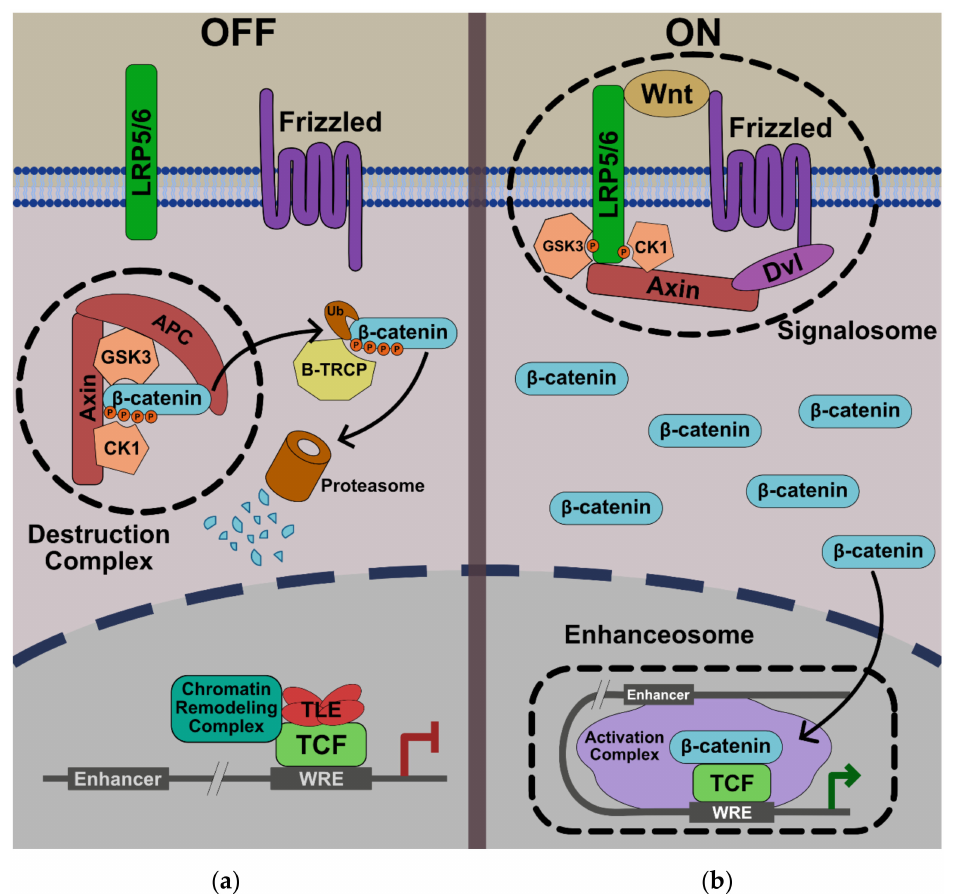
Figure 1. Model of the Wnt pathway. ( a )—ln the absence of Wnt ligand, the β -catenin β destruction complex maintains low cytoplasmic levels of β -catenin. ( b )—In the presence of Wnt ligand, the signalosome is assembled and the β -catenin degradation is disrupted. Entry of β -catenin into the nucleus promotes the formation of the enhanceosome to drive the transcription of Wnt target genes. See text for more